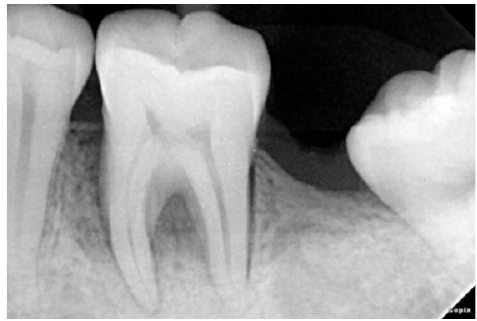
Figure 4. Three Month Post-Operative Radiograph of 36 treated with AM + NB .